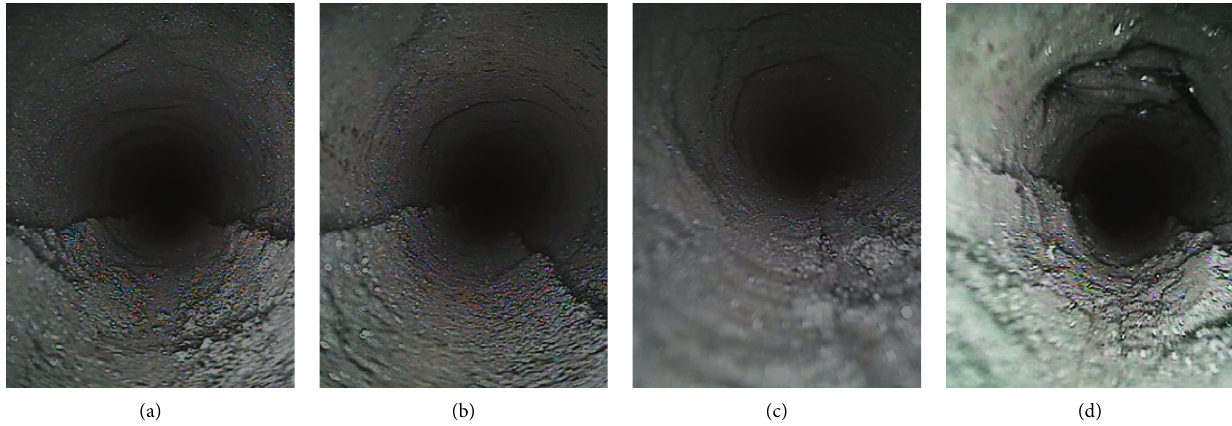
Figure 2: Typical cracks in borehole images. (a) Small crack. (b) Medium crack. (c) Large crack. (d) Broken